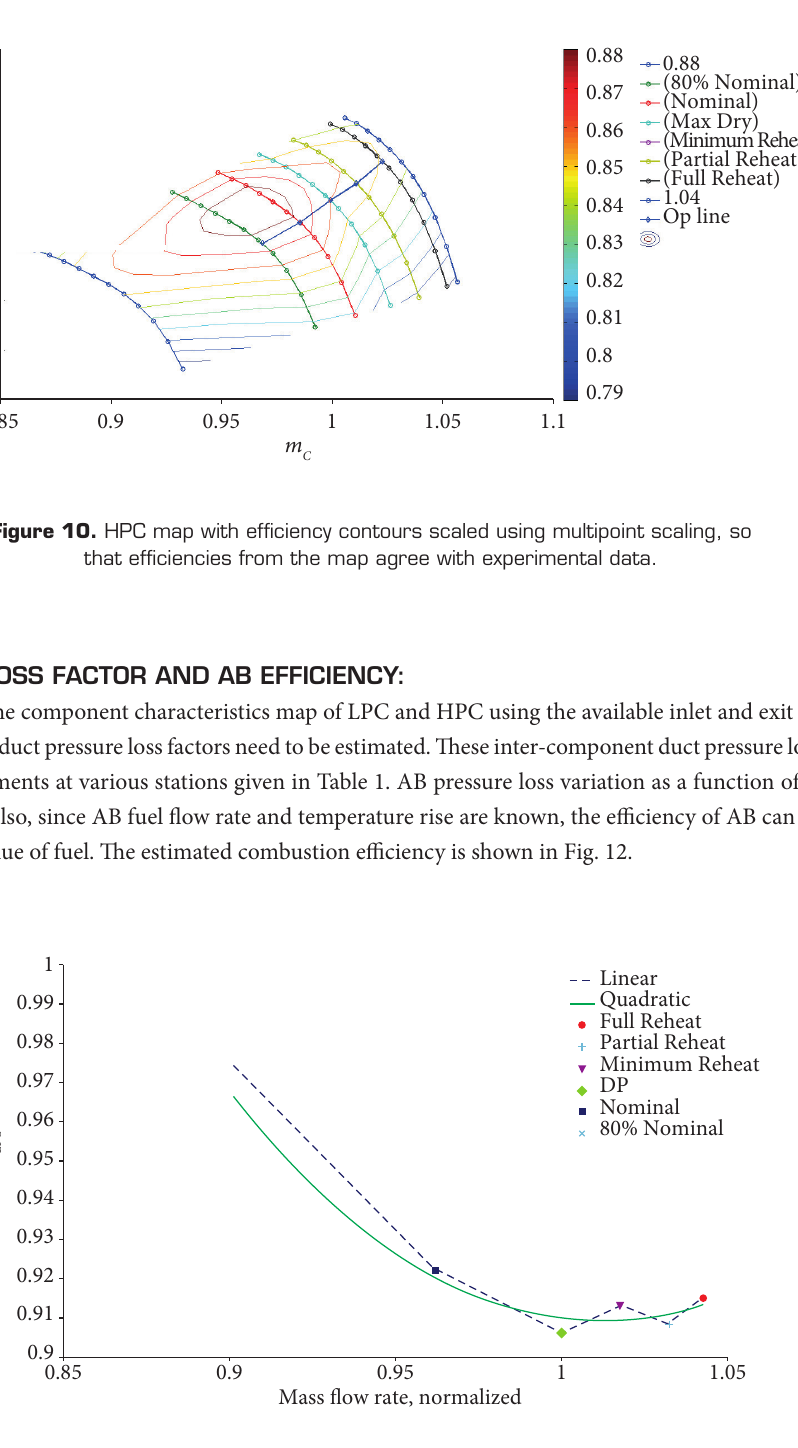
Figure 11. AB pressure loss factor estimated as a function of normalised mass flow rate.